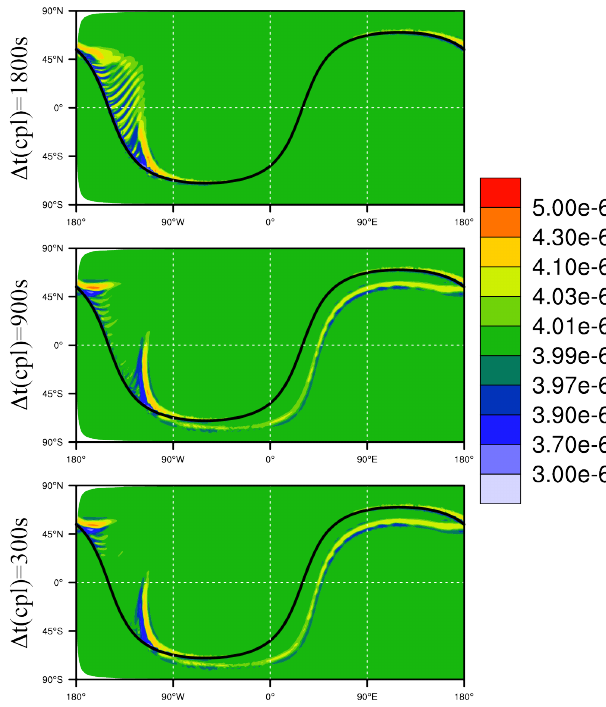
Figure 6. Contour plots of X T at day 1 using CAM-SE based on (upper) (cid:49)t cpl = 1800s, (middle) (cid:49)t cpl = 900s, and (lower) (cid:49)t cpl = 300s, respectively. In all simulations, the tracer and chem- istry time step is constant: (cid:49)t tracer = 300s and (cid:49)t chem = 1800s,